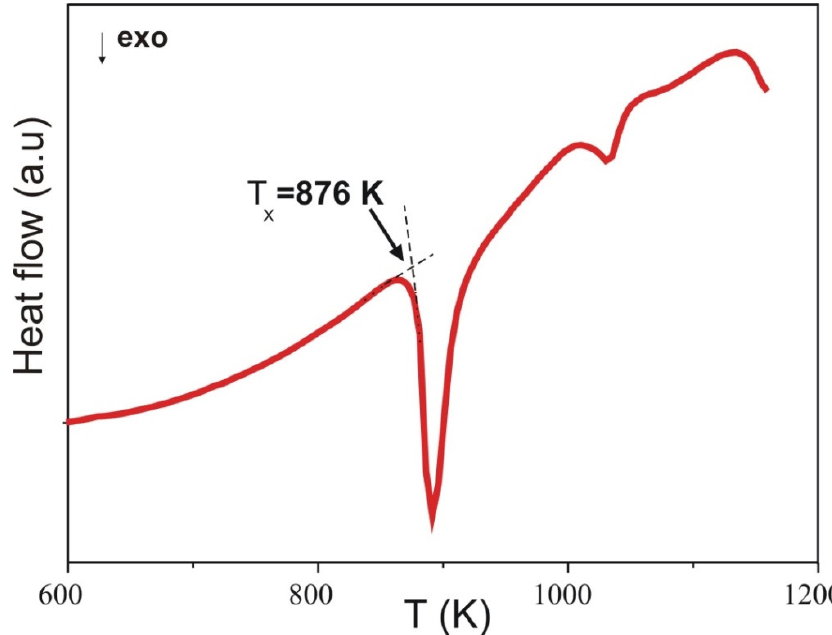
Figure 2. DSC curves for investigated Fe 60 Co 12 Gd 4 Mo 3 B 21 alloys. Tx: the onset of the primary crys- Figure 2. DSCcurvesforinvestigatedFe 60 Co 12 Gd 4 Mo 3 B 21 alloys. Tx: theonsetoftheprimarycrystallization. tallization.